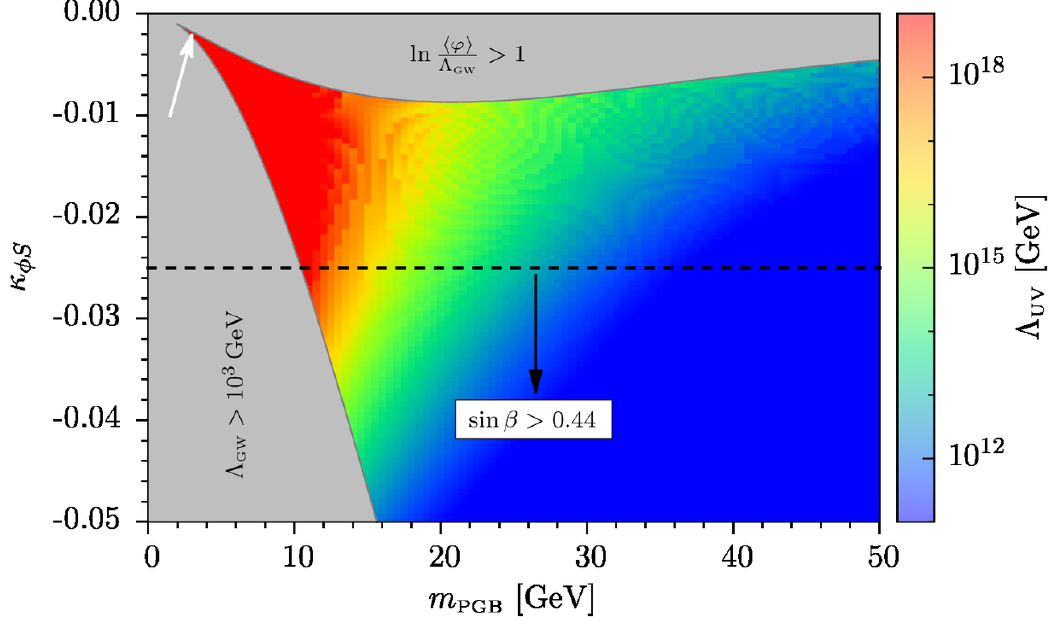
Figure 7 . Largest possible UV scale in the CSM2S. (Case in which the physical Higgs is not the PGB, i.e. (cid:12) > 0.) The white arrow marks the example point from eq.